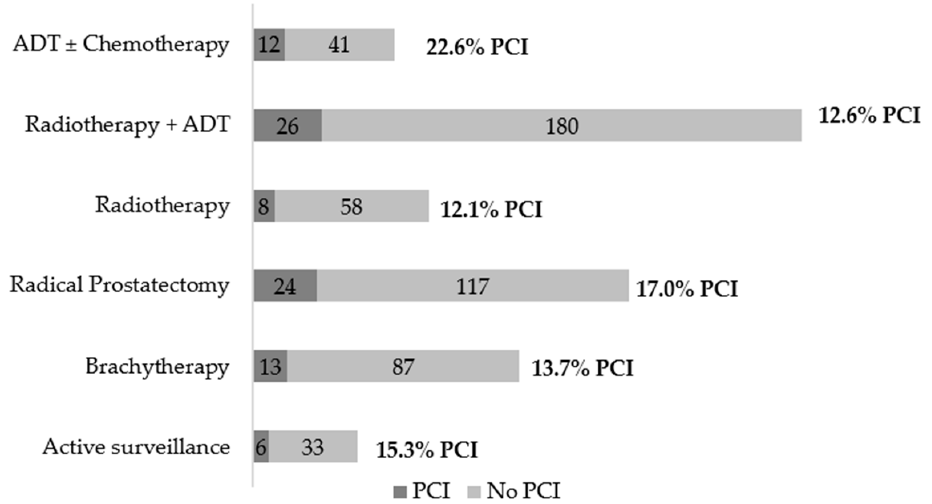
Figure 1. Participants with probable cognitive impairment (PCI) according to the proposal of treatment.